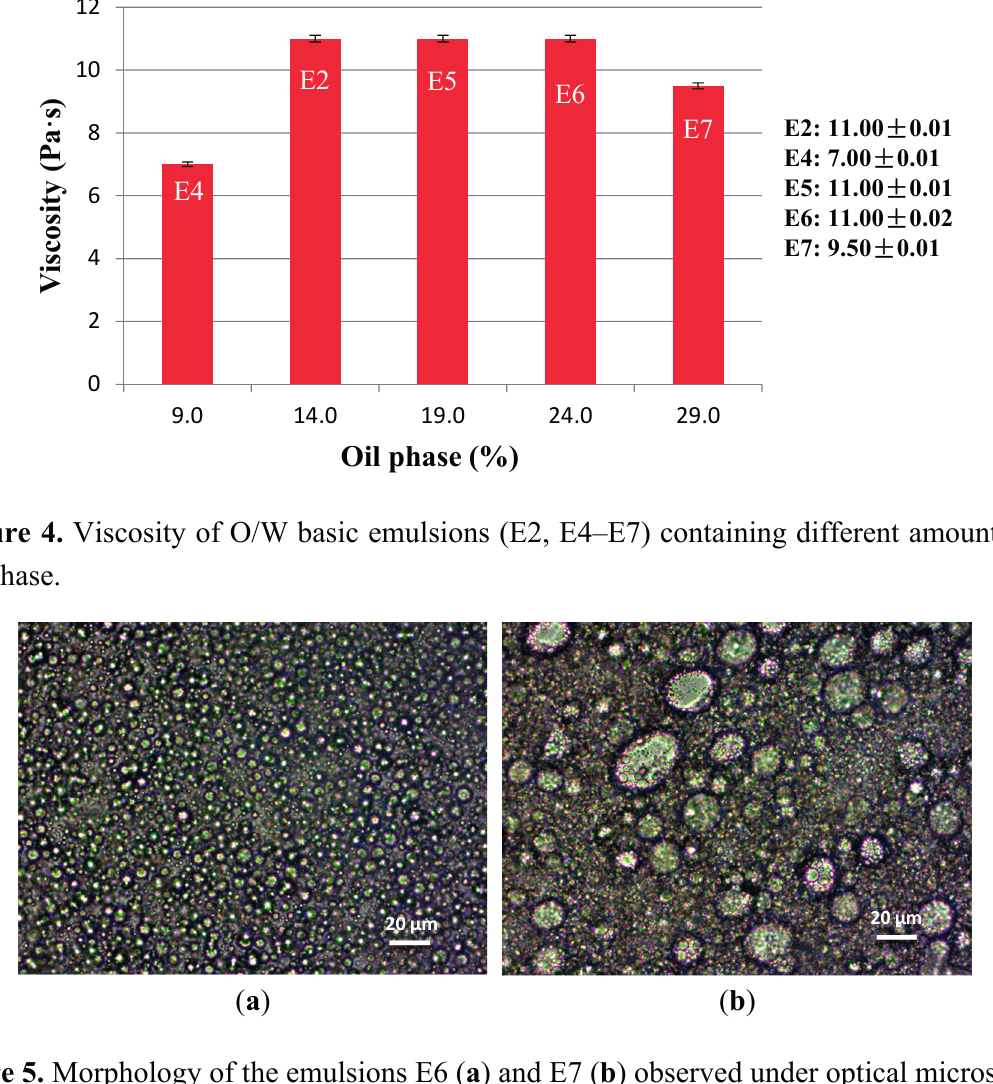
Figure 5. Morphology of the emulsions E6 ( a ) and E7 ( b ) observed under optical